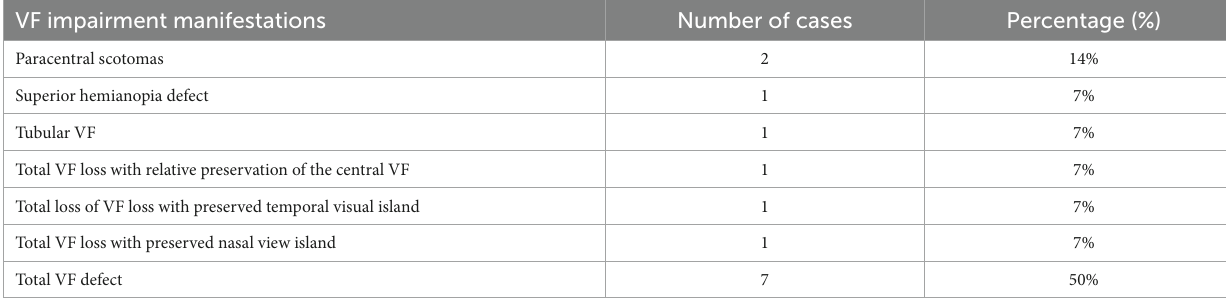
TABLE 3 VF impairment results in the 1st month after the onset of the disease. VF impairment manifestations Number of cases